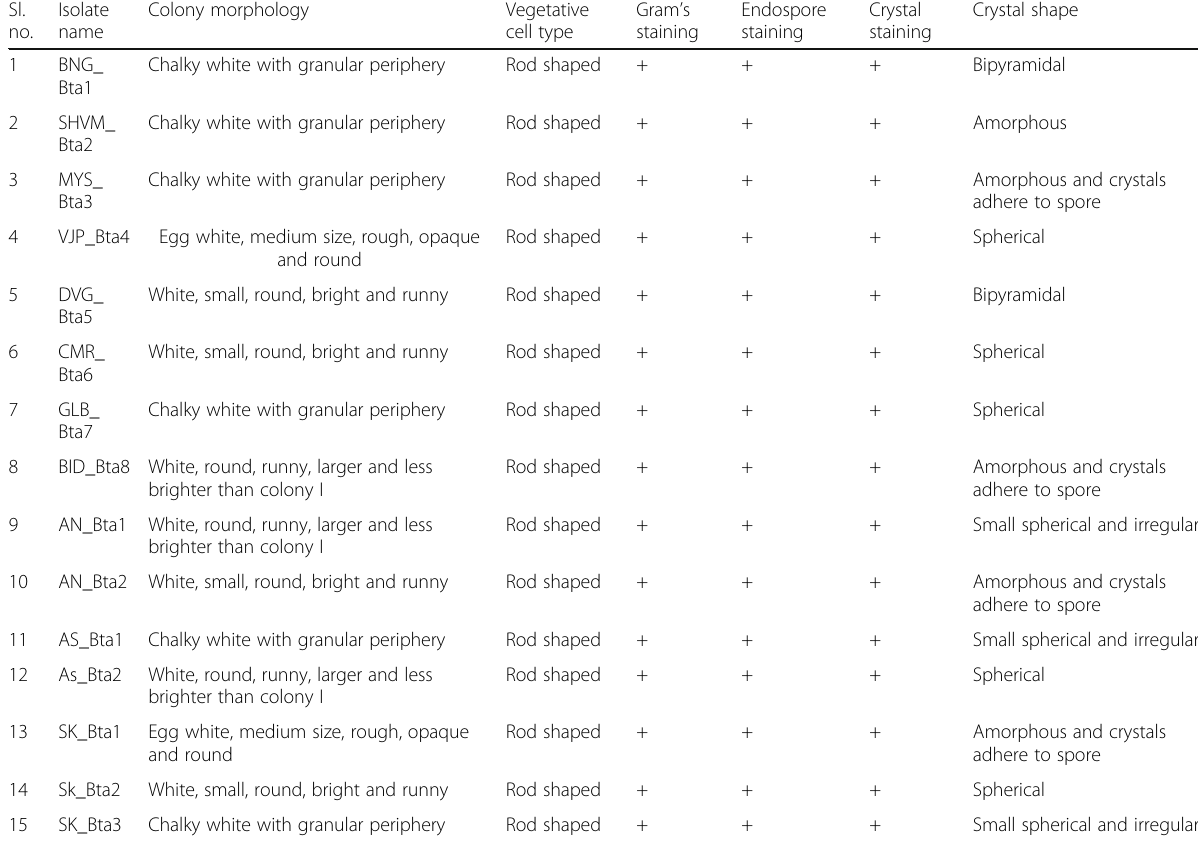
Table 3 Colony morphology, vegetative cell type, microscopic studies and crystal shape of native B. thuringiensis isolates. Sl.